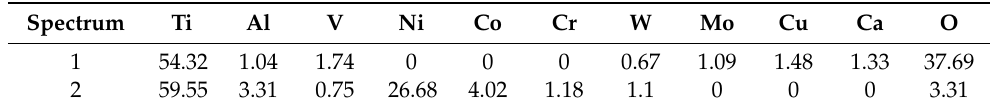
Table 3. EDX-analysis of inclusions in stir zone of sample 4.